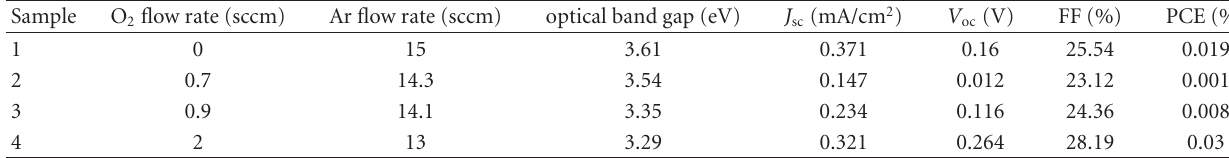
Table 1: Average PV performances of various AZO thin films in devices with MEH-PPV.